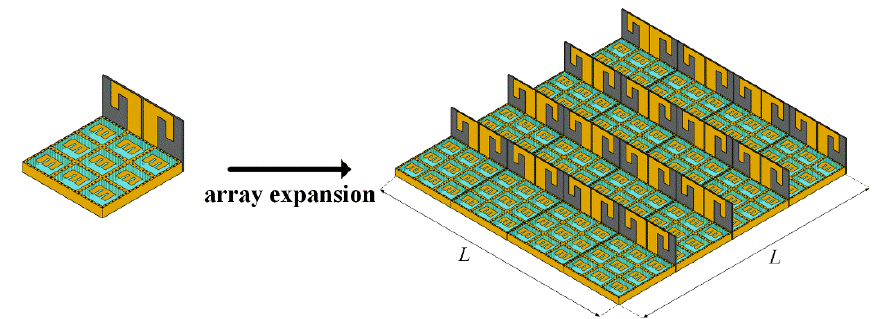
Figure 7. Simulated and measured steering array beam patterns at 9.5 GHz.